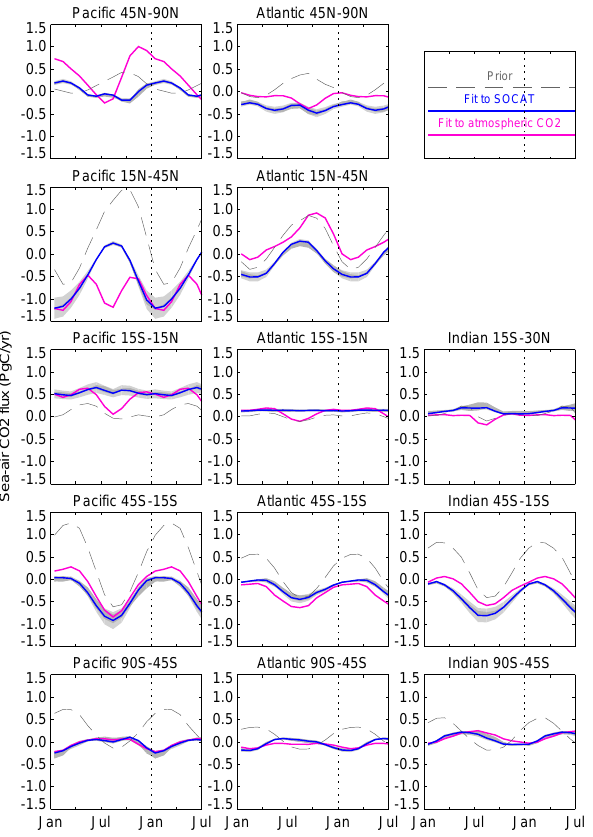
Fig. 12. Mixed-layer phosphate concentration (monthly climatol- ogy, mean subtracted). Seasonality inferred from the SOCAT fit (blue) assumes all ocean-internal carbon sources and sinks are re- lated to phosphate sources and sinks in Redfield proportions. For comparison, the PO 4 climatology from the World Ocean Atlas (WOA, Garcia et al., 2006) is given (green). The grey uncertainty band around the SOCAT-based estimates again gives the range of sensitivity cases as in Figure 7; note however that calculated PO 4 is also sensitive to several further model elements not included in this range.